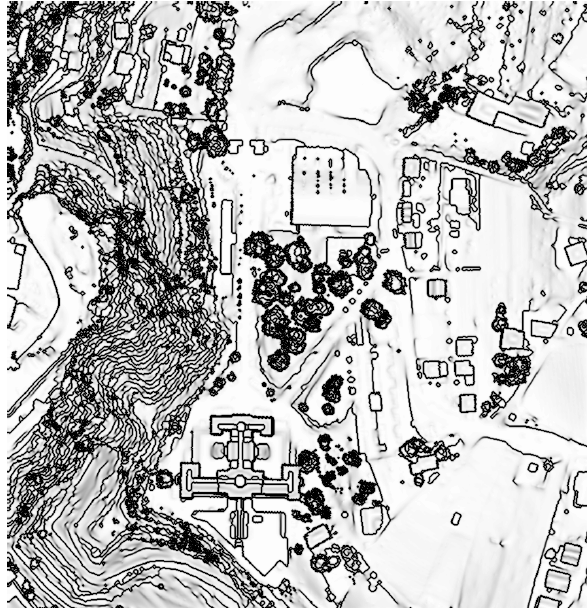
neous regions detected after the application of the Mumford-Shah model.